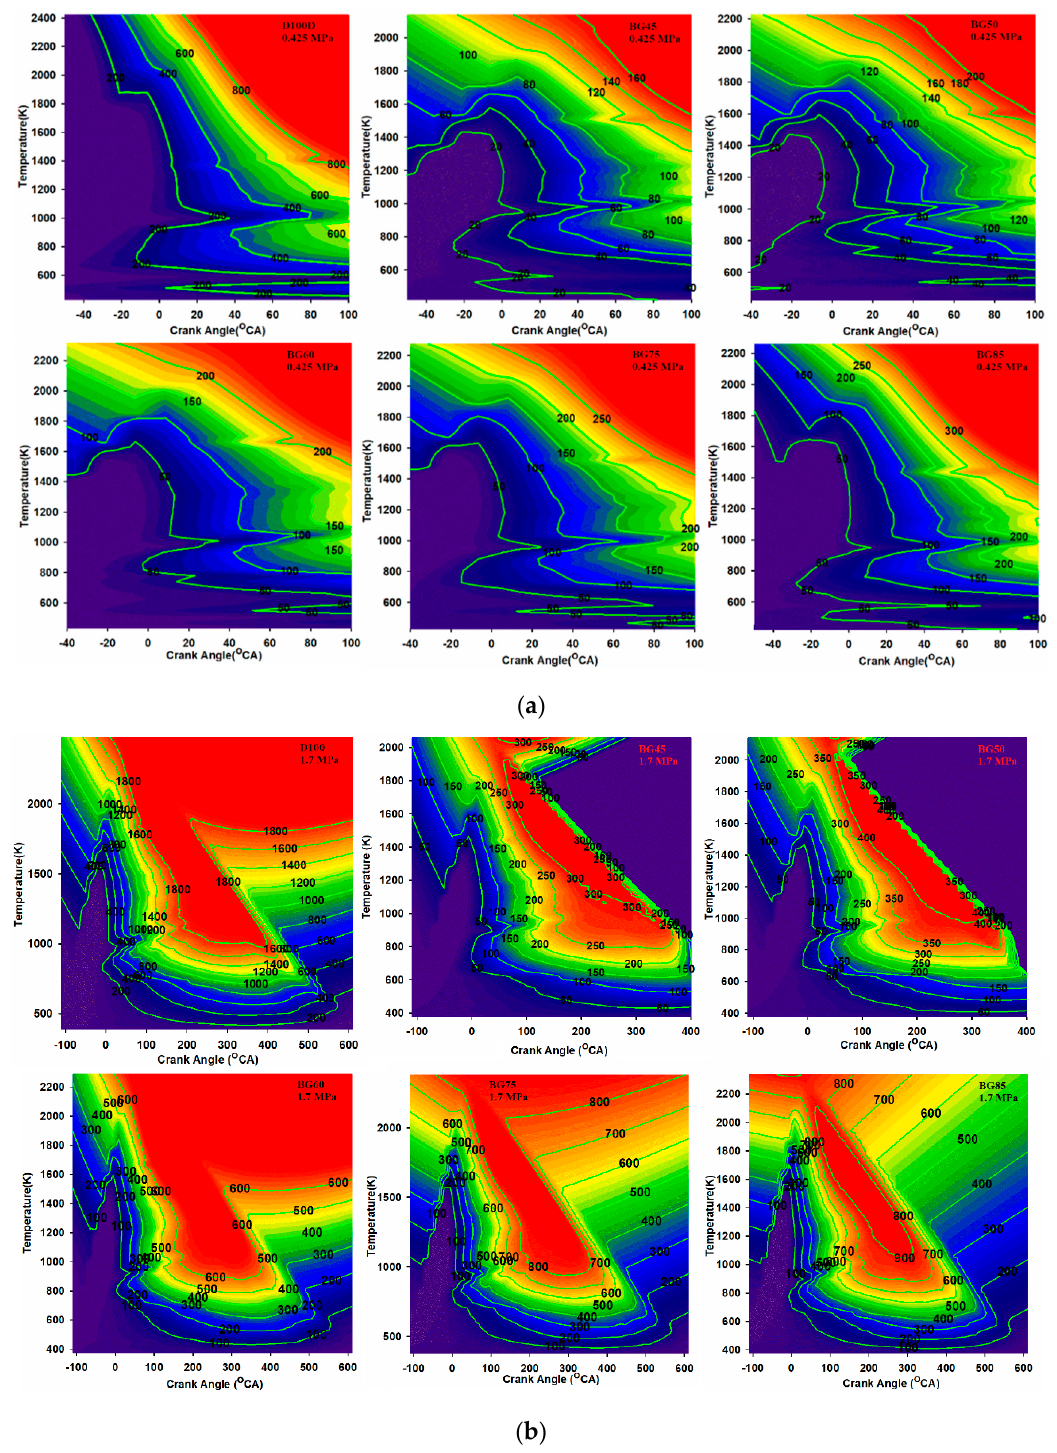
Figure 15. NO X distribution. ( a ) 0.425 MPa ( b ) 1.7 MPa.